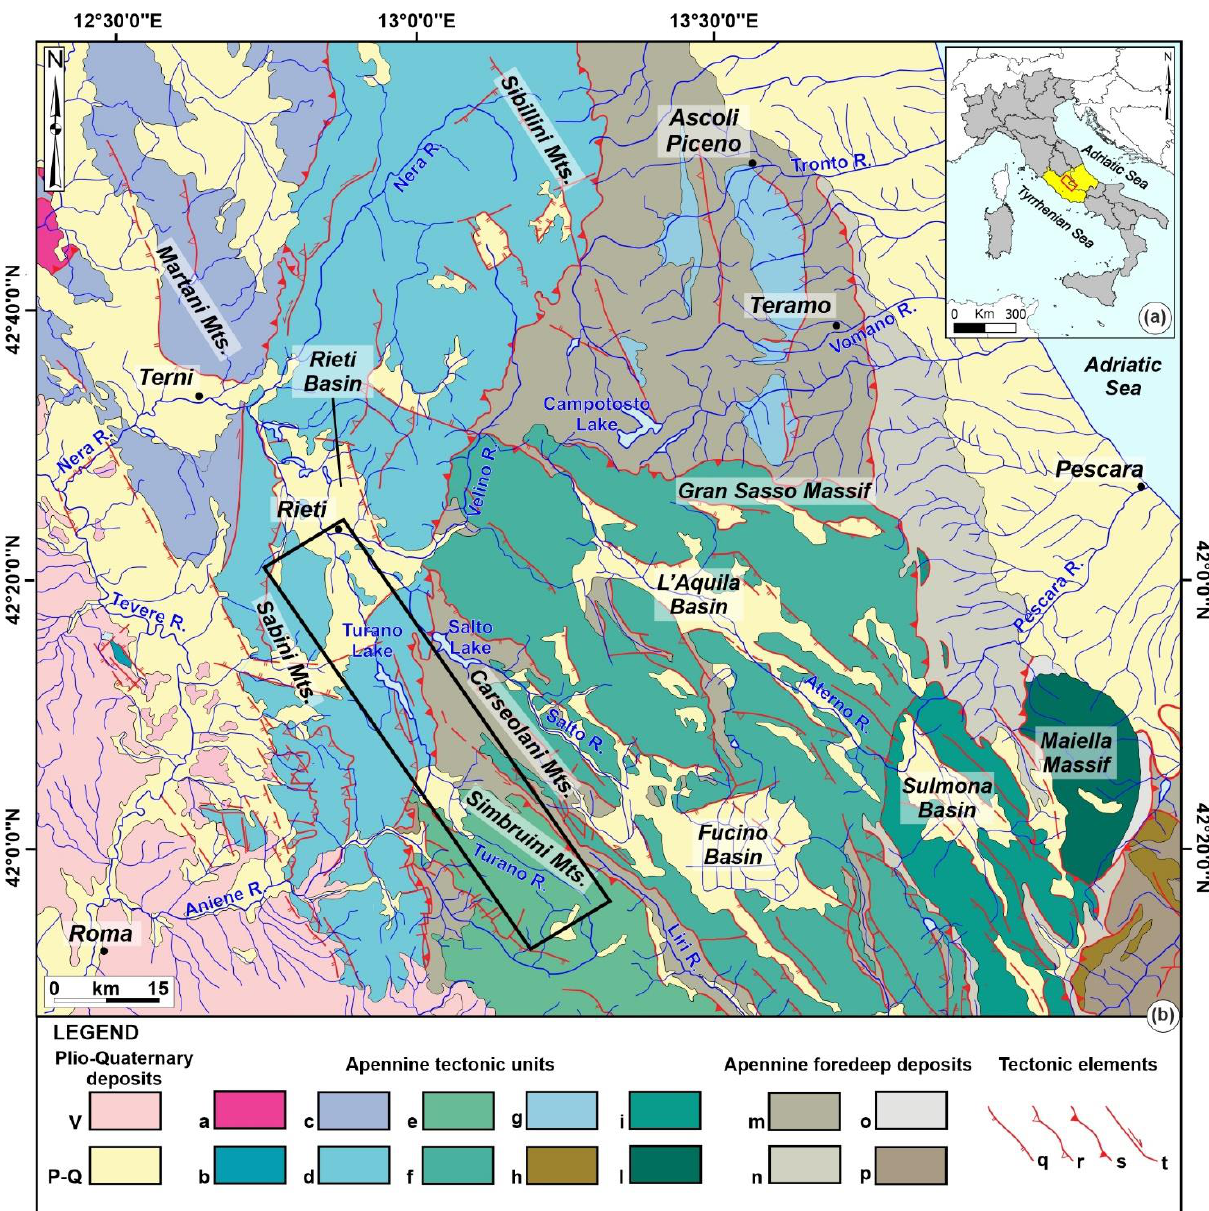
Figure 1. ( a ) Location map of the study area (red box) in Central Italy; ( b ) simplified structural map of Central Apennines (modified from [9]). Legend: (V) Volcanic deposits; (P-Q) Plio-Quaternary marine and continental deposits; (a) External Ligurian unit; (b) Mt. Soratte tectonic unit; (c) Inner Umbria tectonic unit; (d) Umbria-Marchean-Sabine tectonic unit; (e) Simbruini-Ernici tectonic unit; (f) Gran Sasso – Western Marsica tectonic unit; (g) Acquasanta-Montagnone tectonic unit; (h) Molise tectonic unit; (i) Morrone – Eastern Marsica tectonic unit; (l) Maiella tectonic unit; (m) Messinian foredeep deposits; (n) Upper Messinian – Lower Pliocene foredeep deposits; (o) Lower Pliocene foredeep deposits; (p) Molise allochthonous deposits; (q) normal fault; (r) minor thrust; (s) major thrust; (t) strike-slip fault. The black box represents the study area.